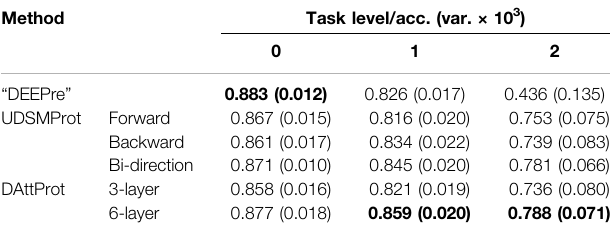
TABLE 2 | Performance results on DEEPre